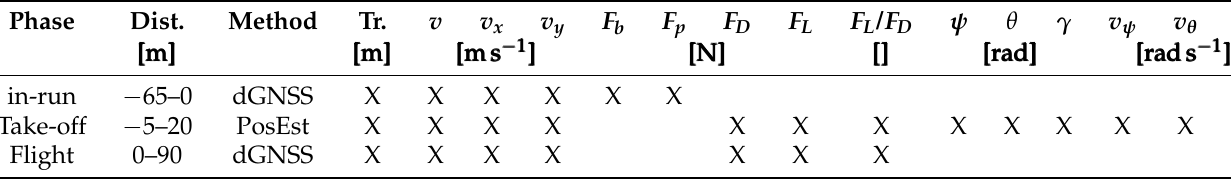
Table 1. Overview of the performance parameters measured in the different phases of the ski jump and the method used for the analysis. Dist. is the horizontal distance from the jump edge and Tr. the trajectory of the head for the dGNSS and CoM for the